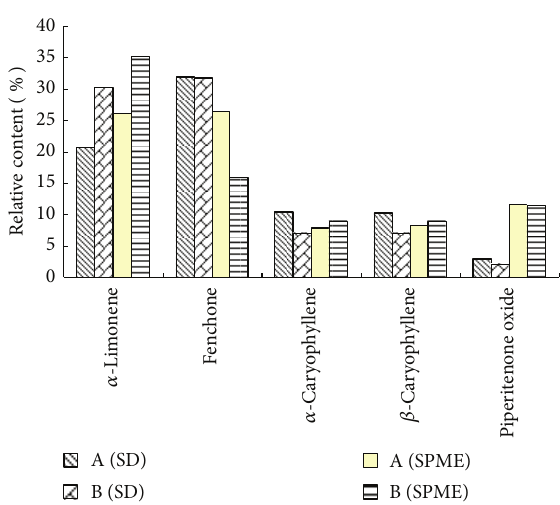
Figure 2: The five major volatile components of A. indianum (Lour.) Merr. obtained by SD and HS-SPME from regions A (Guangxi province) and B (Guangdong province),